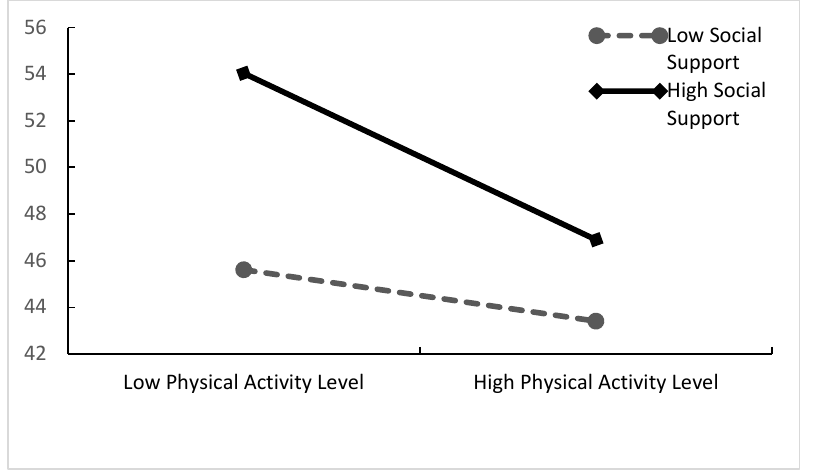
Figure 3. The moderating role of social support between physical activity and mental depression.